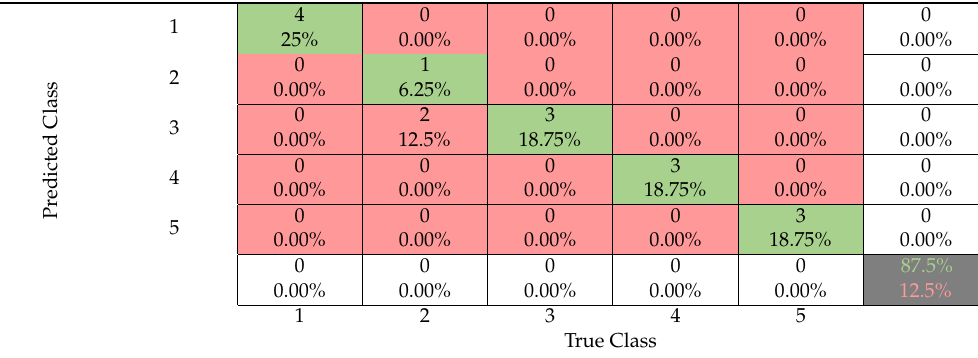
Table 2. The confusion matrix for the SVM activity intensity classifier shows the classification accuracy for our methodology applied to data from multiple test subjects. Misclassification occurs solely between levels 2 and 3.